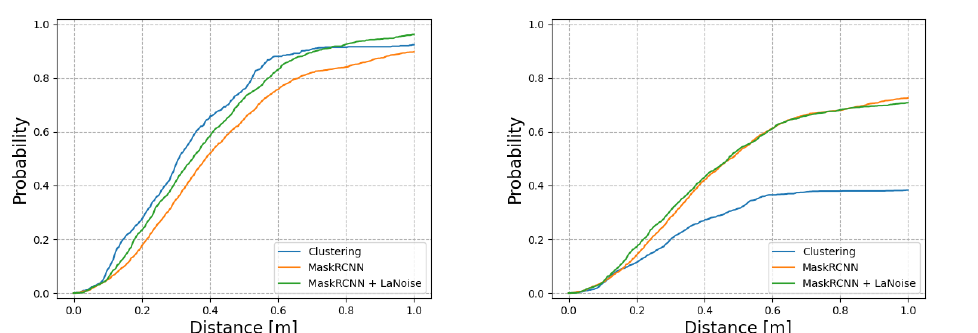
Figure 8. The performance of the detectors in good weather conditions. ( Left ): The probability of there being a car in the ground-truth labels within a certain distance of a detection. ( Right ): The probability of a car detection being made within a certain distance of a ground-truth label. The results show the benefits of using an auto-labelling-based approach to car detection, where approaches both with and without weather simulators outperformed the clustering method method from which they were taught.The two neural network-based approaches perform relatively similarly in good weather